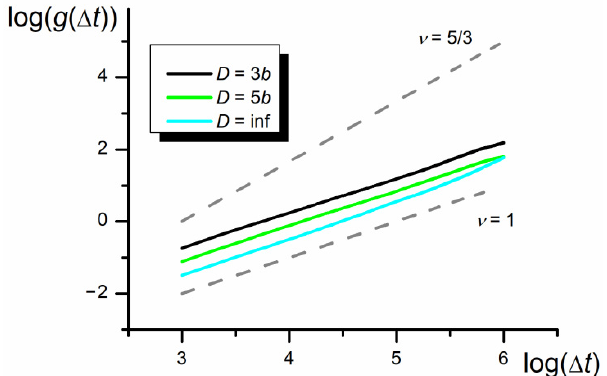
Figure 7. The log–log plot of the autocorrelation function, g, in the nanochannel for different chain lengths ( D = 3 b , ε PP / k B T = 0 and − 1 for P1 and P2, respectively). The slopes of di ff usion and quasi-ballistic modes (equal 1 and 5/3) are marked in gray.